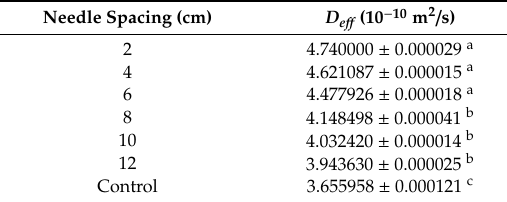
Table 6. Effective moisture diffusion coefficients under different needle spacings.